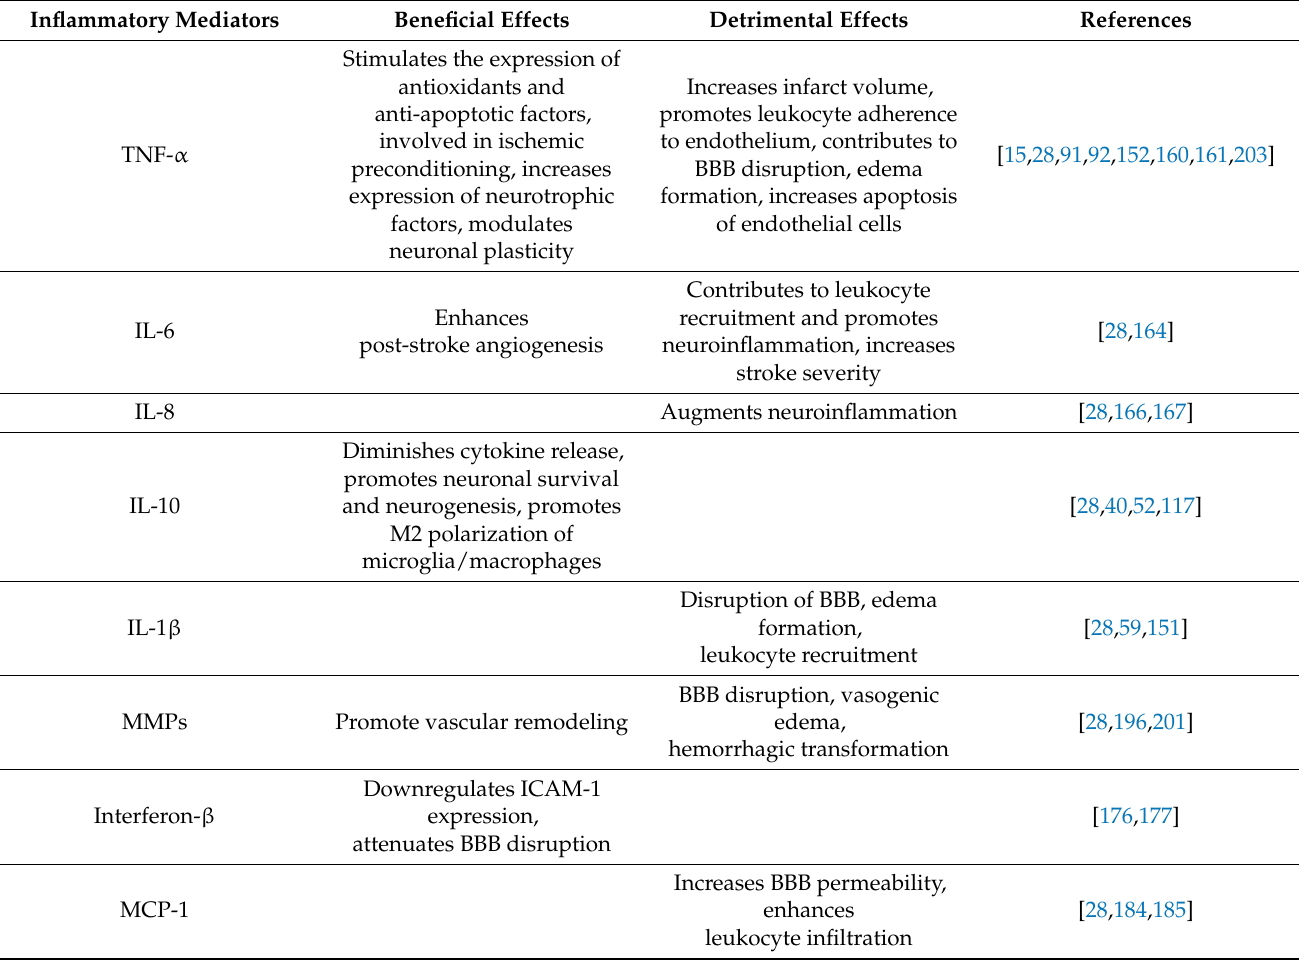
Table 2. Beneficial and detrimental effects of the main inflammatory mediators. Adapted from Jayaraj et al.